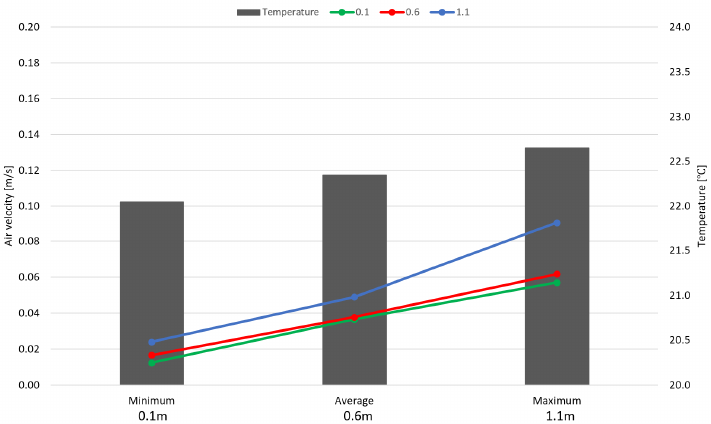
Figure 27. Results for room C facing north, showing the minimum, average, and maximum value for the air velocity measurements at three different heights and the mean temperature on the right axis for the different measuring heights.